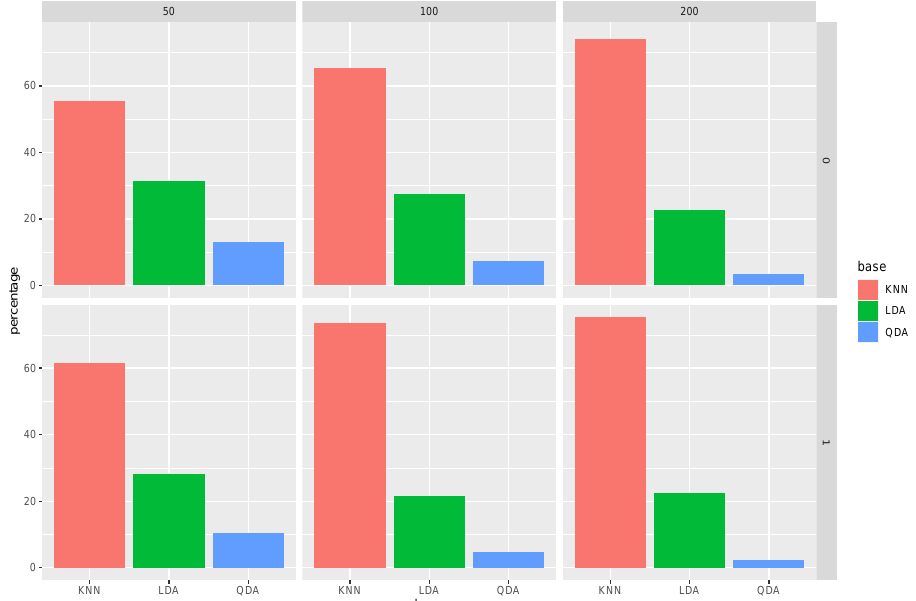
Figure 8. The average selected proportion for each base method for different sample sizes (corre- sponding to each column) and iteration number (corresponding to each row) for the hand-written digits recognition